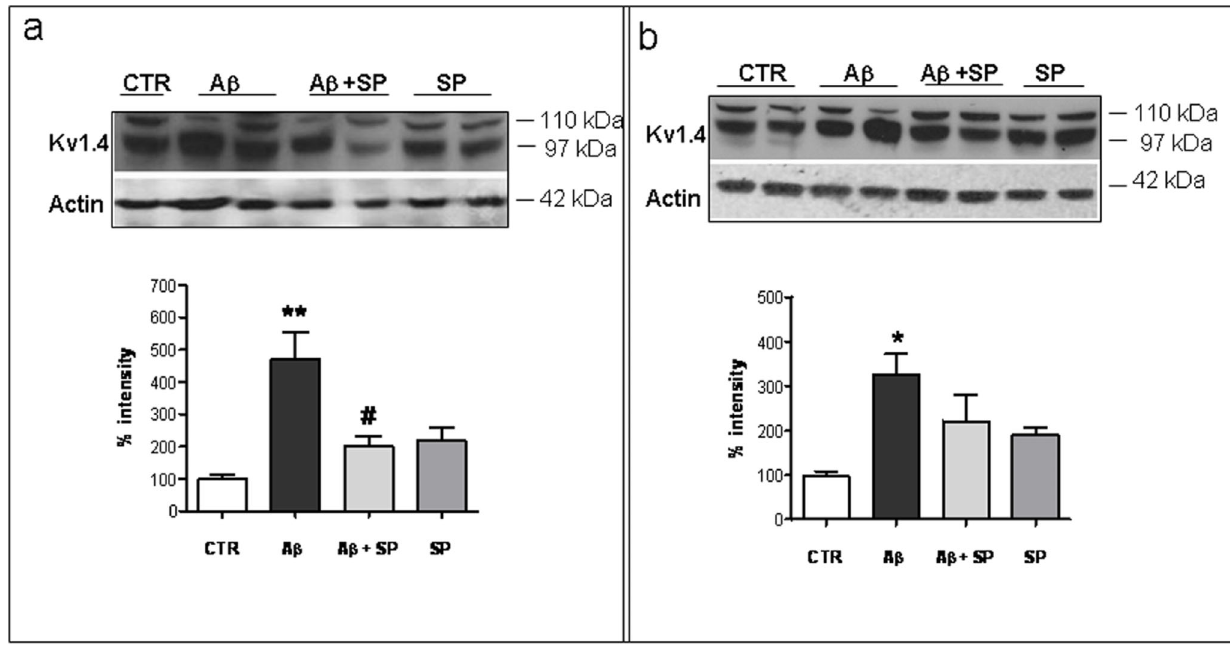
Figure 3. Western blot analysis of Kv1.4 subunit expression in hippocampus and cerebral cortex. Representative immunoblot of ( a ) hippocampus and ( b ) cerebral cortex enriched membrane proteins (50 m g/lane) from (Ctr), A b 25–35 , A b 25–35 + SP and SP treated rats. Protein markers are shown at right (in kDa). The immunoreactive signals at 97 and 110 kDa were quantified and normalized against b -actin and expressed as a percentage of the control (Ctr). Data represent mean ( 6 SEM) from 5 independent experiments. Statistically significant differences were calculated by one-way analysis of variance (ANOVA) for repeated measures followed by Tukey’s test for multiple comparisons (**p , 0.01 versus Ctr value; # p , 0.05 versus A b 25–35 treatment).